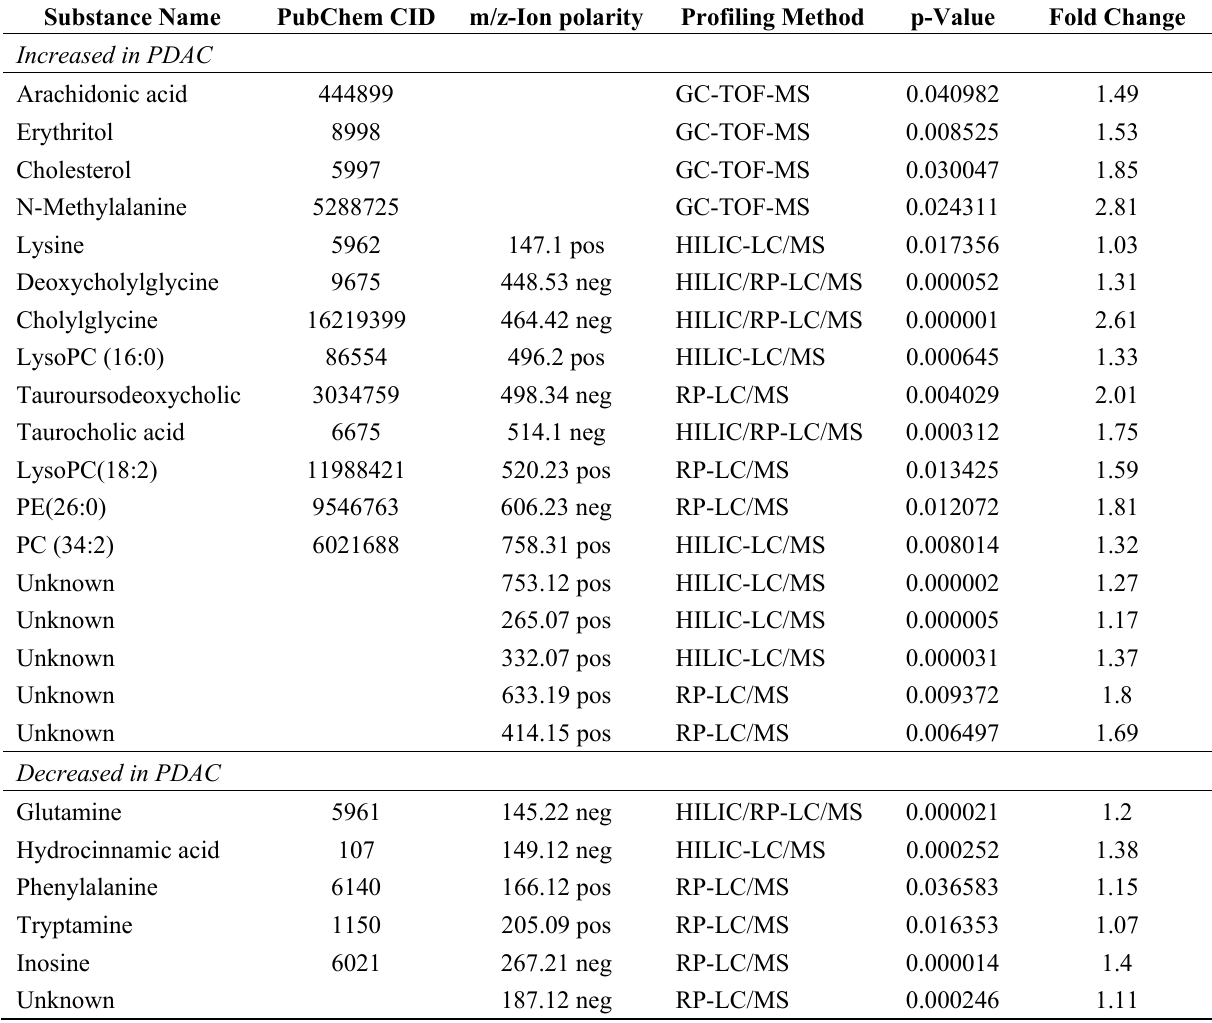
Table 1. Putative biomarkers for pancreatic ductal adenocarcinoma